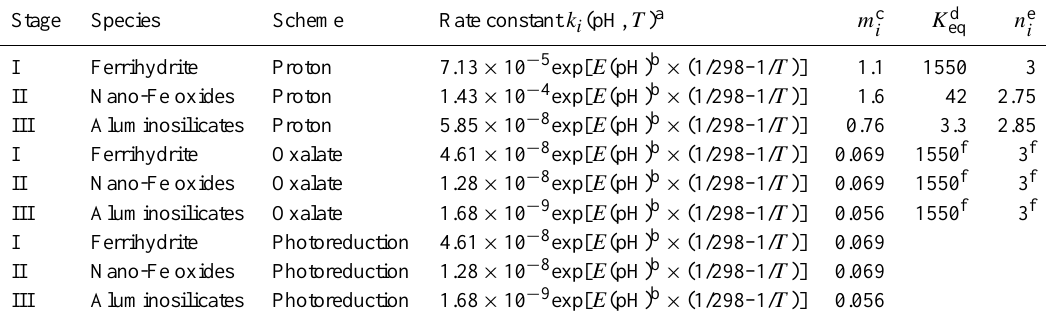
Table 3. Constants used to calculate Fe dissolution rates for mineral dust, based on laboratory experiments. Stage